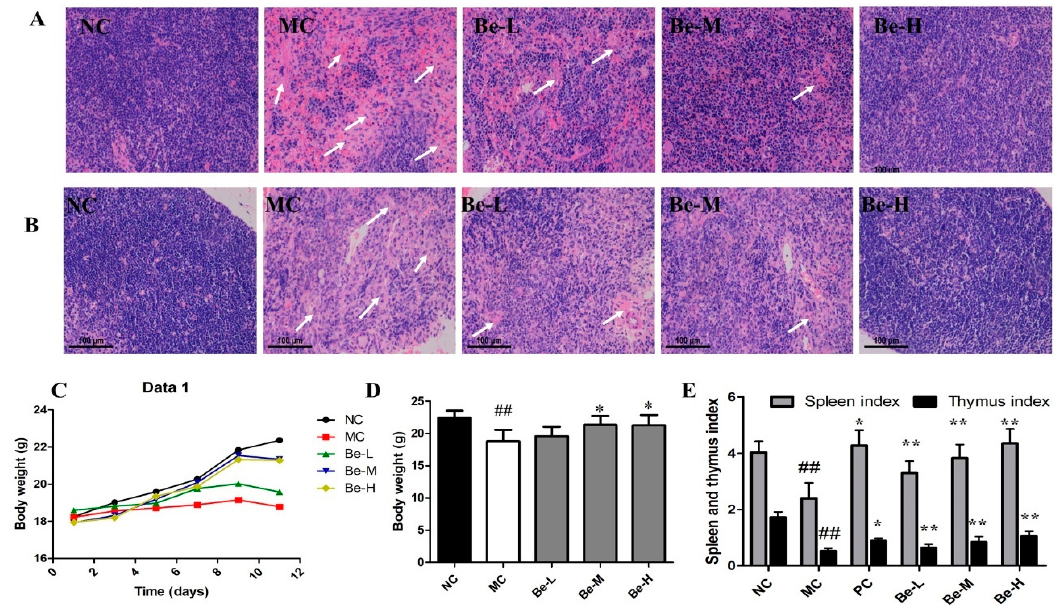
Figure 1. Effects of bergenin on spleen and thymus tissues in Cy-treated mice. ( A ) Spleen tissues in the HE stained histopathological images (objective: 100 × ). ( B ) Thymus tissues in the HE stained histopathological images (objective: 100 × ). ( C ) Body weights during treatment. ( D ) Body weights after treatment. ( E ) Immune organ indices. NC: normal control group, dosed with saline; MC: model control group, treated with cyclophosphamide; Be-L: challenged with Cy and treated with 5 mg/kg/day bergenin; Be-M: challenged with Cy and treated with 10 mg/kg/day bergenin; Be-H: challenged with Cy and treated with 20 mg/kg/day bergenin. Data are expressed as mean ± SD ( n = 8). ## p < 0.01 vs. the NC group, * p < 0.05 and ** p < 0.01 vs. the MC group.